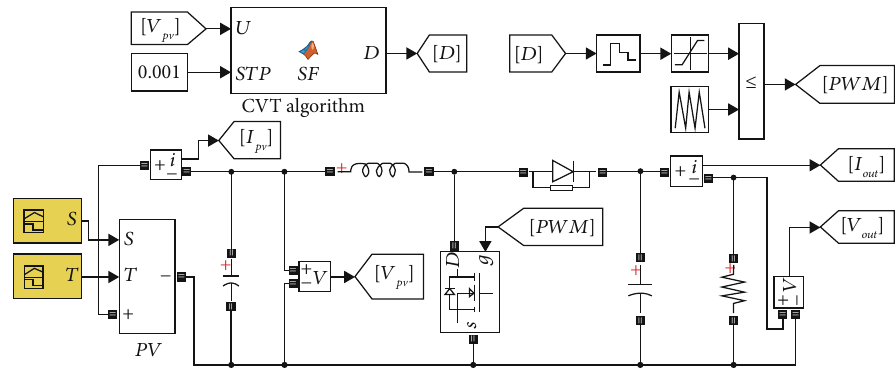
Figure 11: Maximum power point tracking (MPPT) system model. Table 4: Average power and amplitude of algorithms at the operating point (unit: